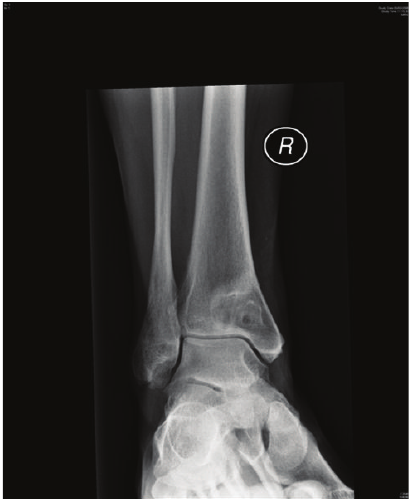
Figure 4: AP X-ray showing reoccurrence of cystic lesion distal